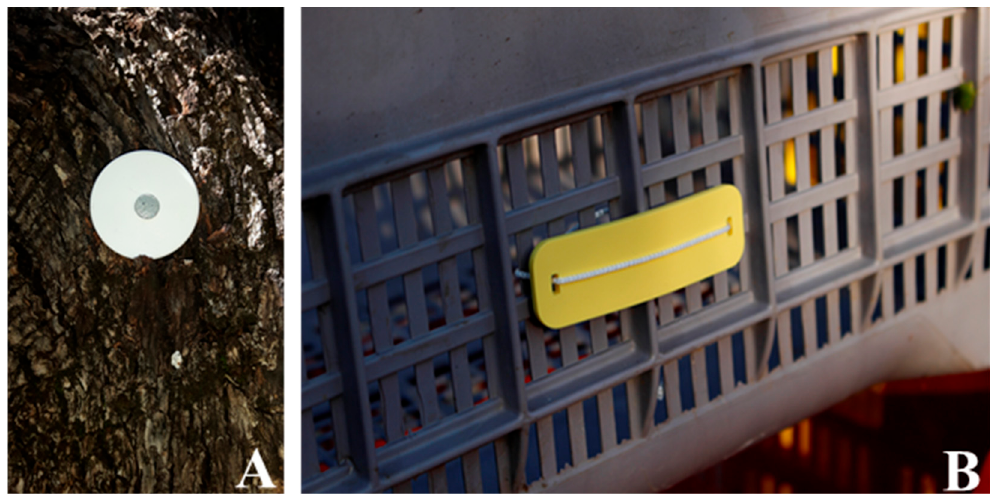
Figure 2. ( A ) The RFID1 standard used is UHF at 860 MHz, Class 1 Gen 2, waterproof coin shaped with central hole; ( B ) the RFID2 is UHF at 860 MHz, waterproof flexible band with two holes at the extremities fixed with a small cord on the crate.